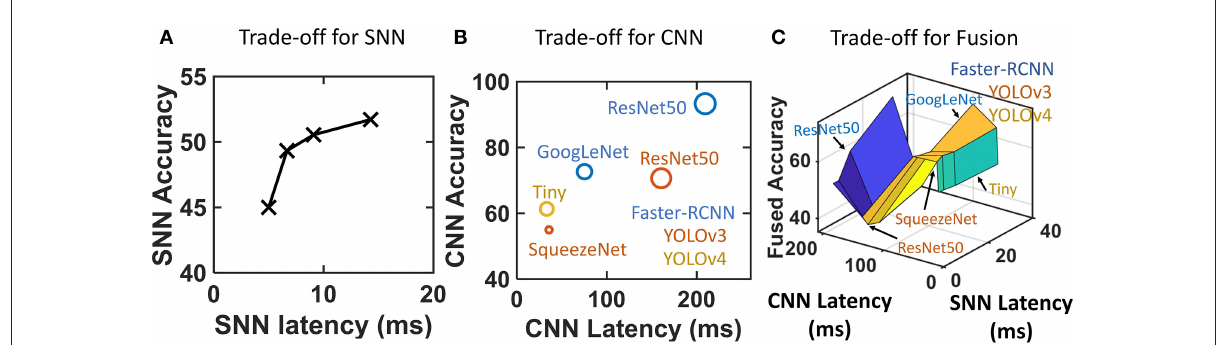
FIGURE11 Both event and frame pipelines have internal accuracy vs. latency trade-offs. (A) Accuracy of the event pipeline increases when the epoch duration is large (lower throughput) with more events to infer from. (B) Different feature extractors and object detectors cause performance trade-offs for CNN. The color coding shows the detector while the feature extractor is denoted in the figure. Resnet50+FasterRCNN is the most accurate while Squeezenet+YOLO is the fastest. (C) Fused accuracy requires an accurate CNN with reasonably high speed for high accuracy. The latency of SNN has a relatively low impact on fused accuracy while it determines the throughput. GoogleNet+FasterRCNN is the most suitable.